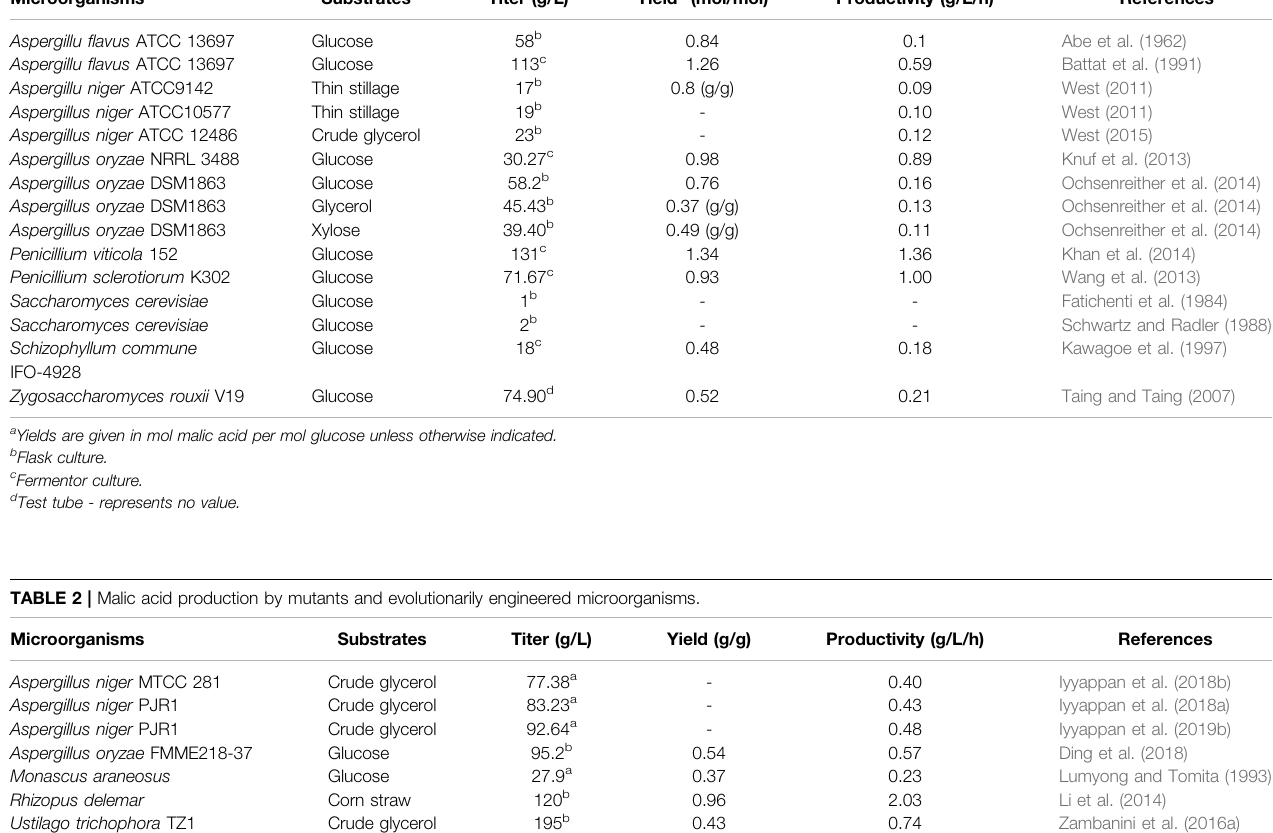
TABLE 1 | Malic acid production by wild type microorganisms. Microorganisms